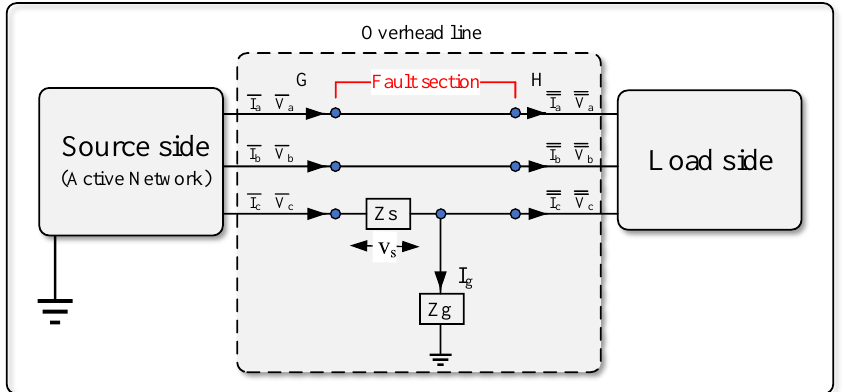
Figure 6. Description of a fault section (including the shunt impedance